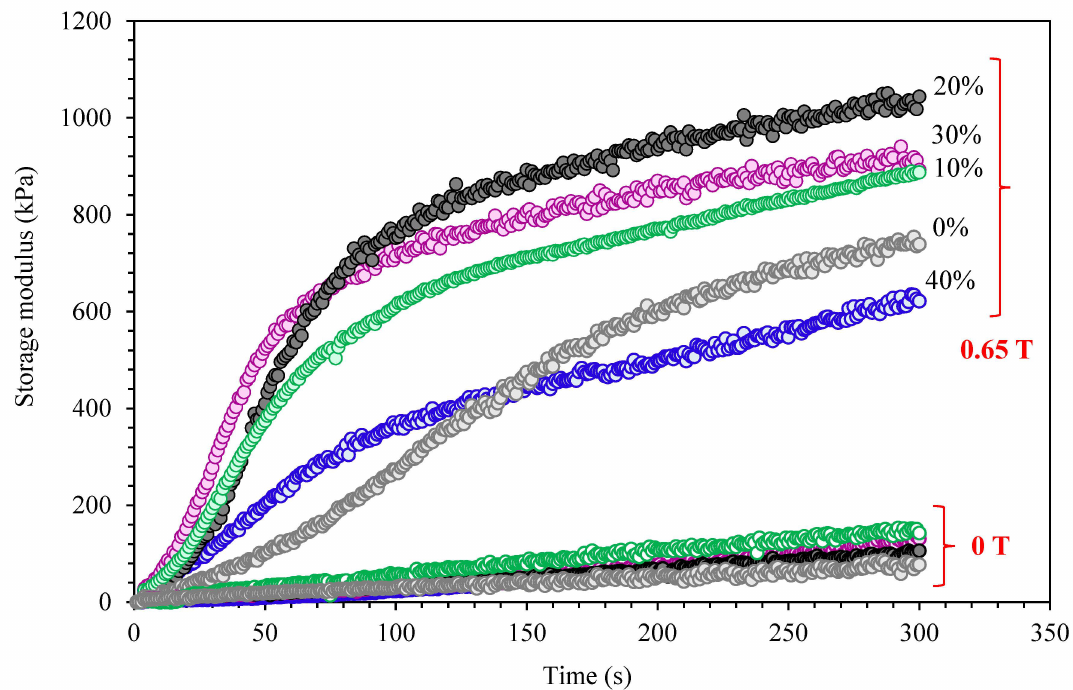
Figure 8. Storage modulus evolution with/out magnetic field